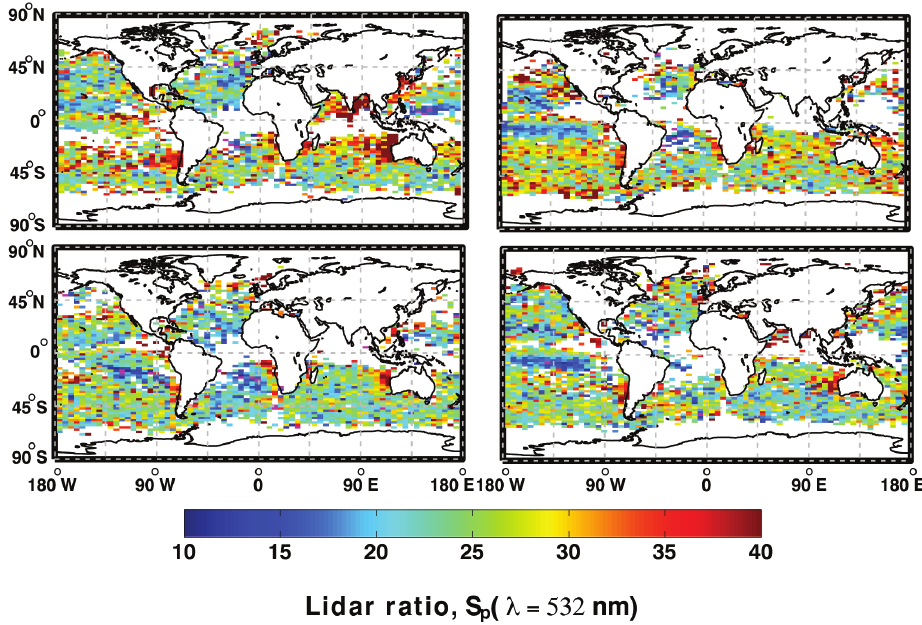
Figure 2. Seasonal lidar ratio for 2 ◦ × 5 ◦ latitude longitude grid cells. Seasons are arranged as (a) December–February, (b) March–May, (c) June–August, (d)